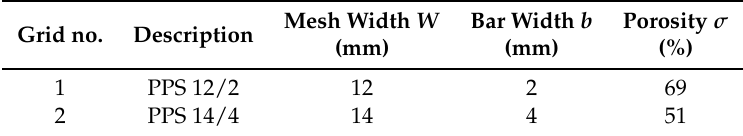
Table 1. Overview of turbulence grids used in the experiments (PPS; perforated plate with square holes). Grid